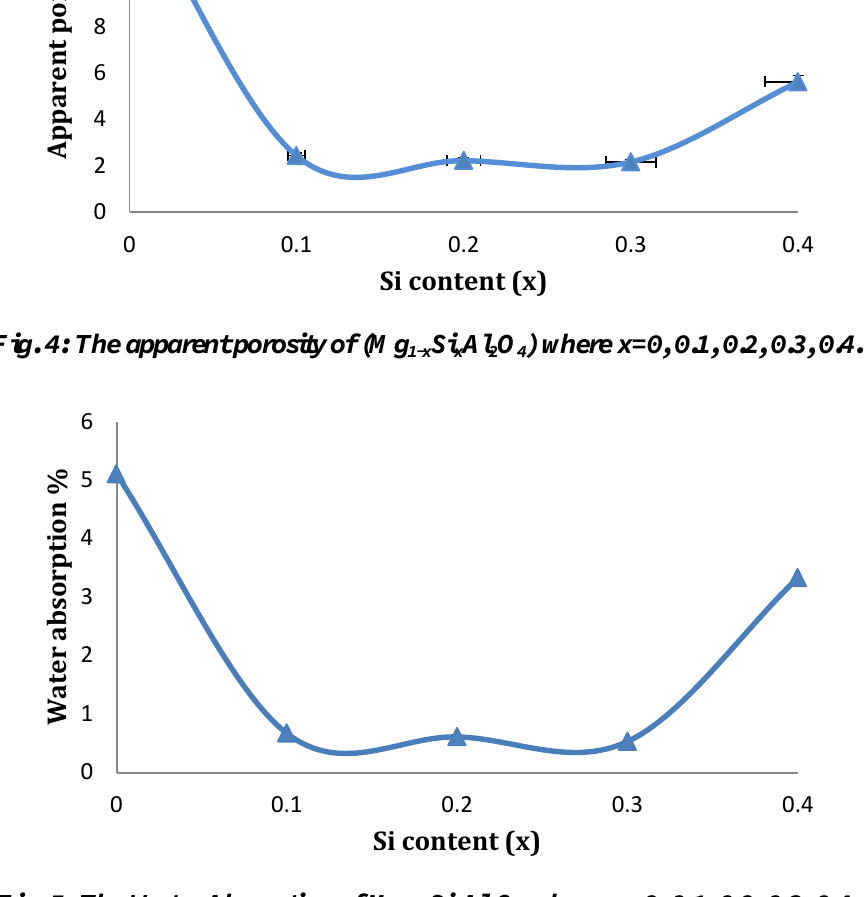
Si Al O where x= 0, 0.1, 0.2, 0.3, 1-x x 2 4